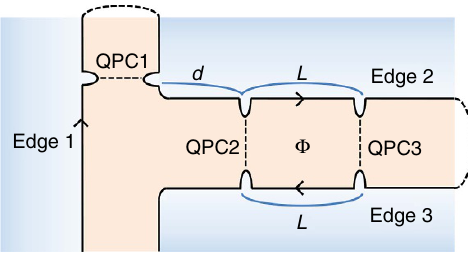
Figure 4 | Extended edge channel scheme. It is obtained by connecting the edge channels of the setup in Fig. 2a. The connection is represented by dashed arcs, whereas anyon propagation direction and anyon tunnelling at QPCs are represented by arrows and dashed